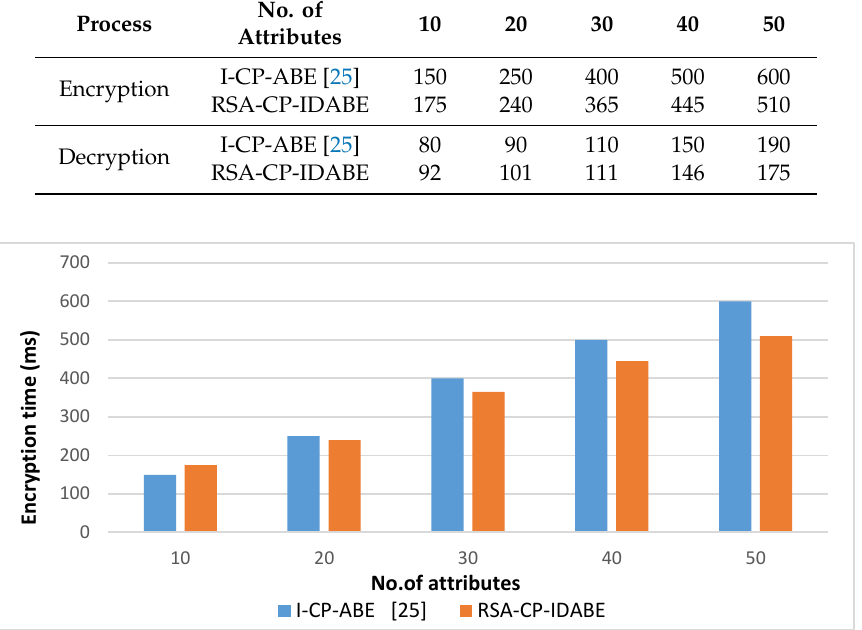
Figure 6. Comparison between the proposed RSA-CP-IDABE and I-CP-ABE for encryption time.